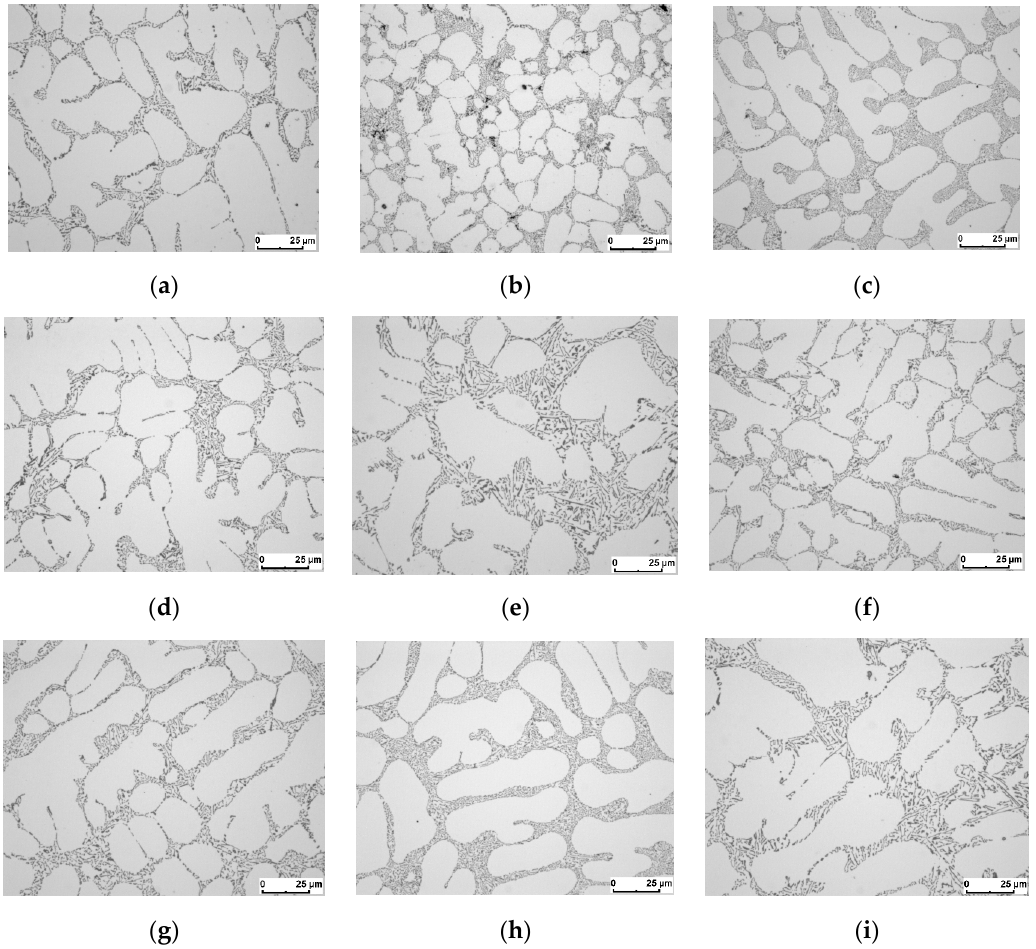
Figure 6. Powder compacts, morphology of the eutectic phase, influence of additive content at high cooling rates. In columns from left to right, additive level is stepped up from 130 to 250 to 465 ppm (Sr, top row, ( a – c )), 260 to 350 to 465 ppm (TiB 2 , center row, ( d – f )) and 70 to 140 to 280 ppm (B, bottom row, ( g – h )). Note the twofold increase in magnification compared to Figure 5.